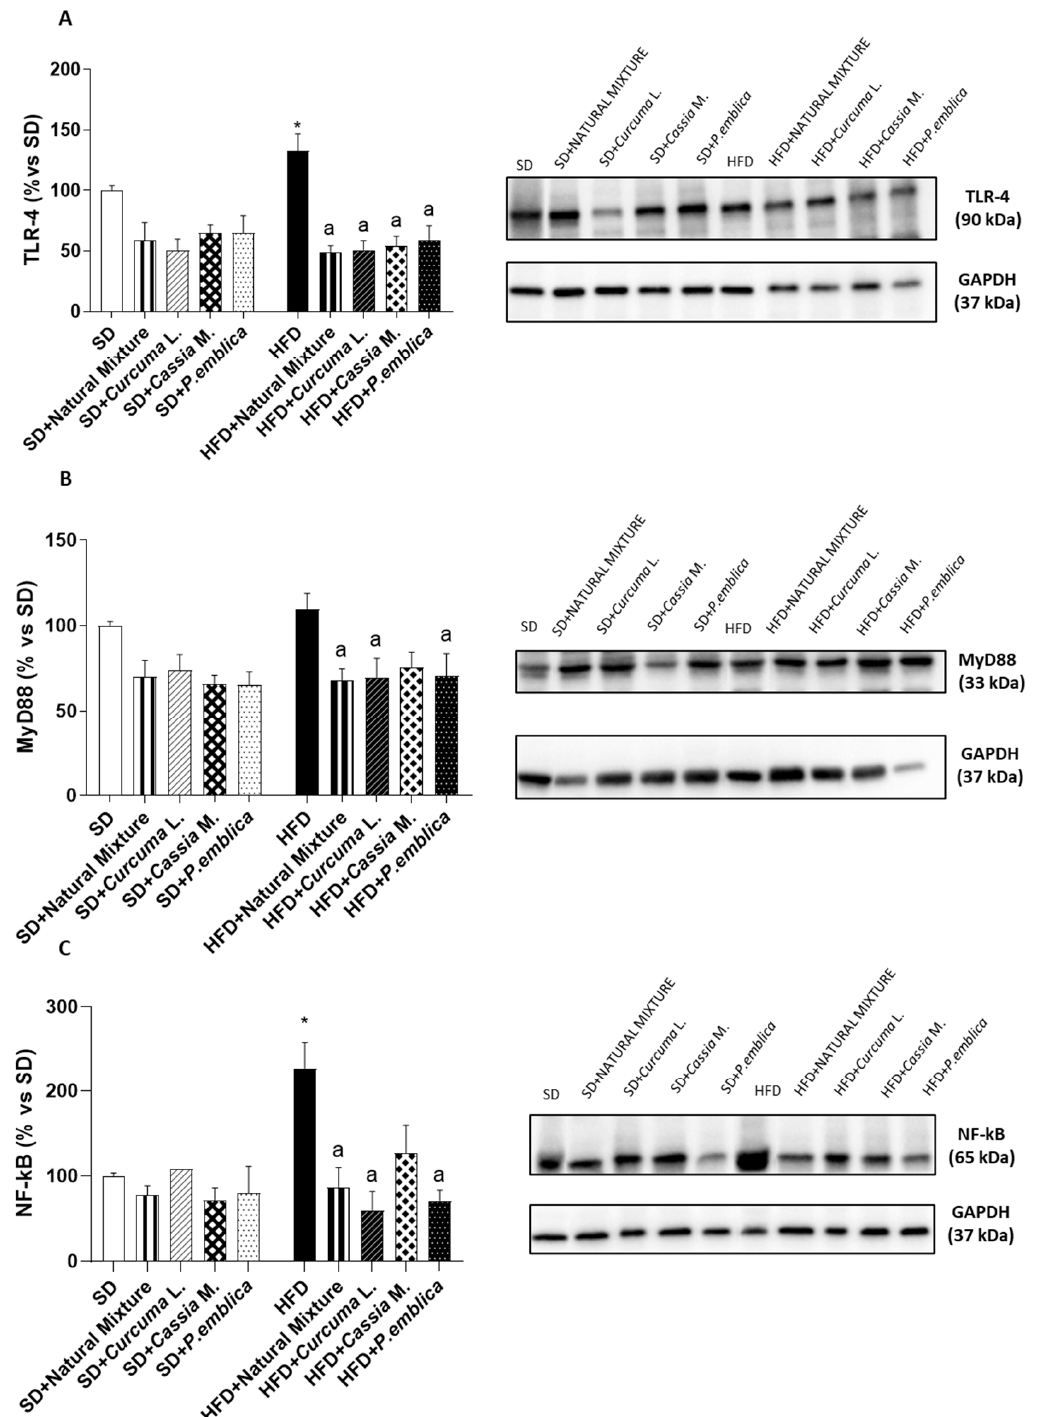
Figure 4. Densitometric analysis and representative blots of the expression of ( A ) TLR-4, ( B ) MyD88 and ( C ) NF-kB in colonic tissues from HFD- or SD-fed mice treated with natural mixtures or with the single components. Each column shows the mean ± SEM ( n = 6). One-way ANOVA are Tukey post hoc test results are as follows: *— p < 0.05 for significant difference vs. the SD group, and a — p < 0.05 for significant difference vs. the HFD group. Abbreviations: HFD—high fat diet; MyD88—myeloid-differentiation primary response-gene 88; NF- κ B—nuclear factor kB; SD—standard diet; TLR-4—toll-like receptor 4; GAPDH—Glyceraldehyde 3-phosphate dehydrogenase.